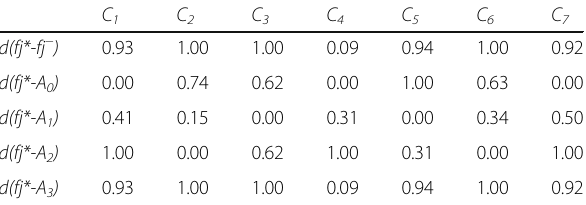
Table 6 Normalized fuzzy distances of